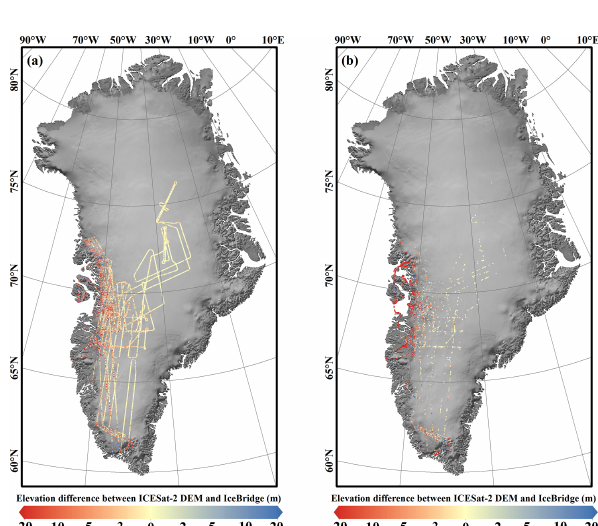
Figure 6. Elevation difference calculated as IceBridge data sub- tracted from the new ICESat-2 DEM. (a) Calculated grids and (b) interpolated grids. IceBridge data were acquired in May